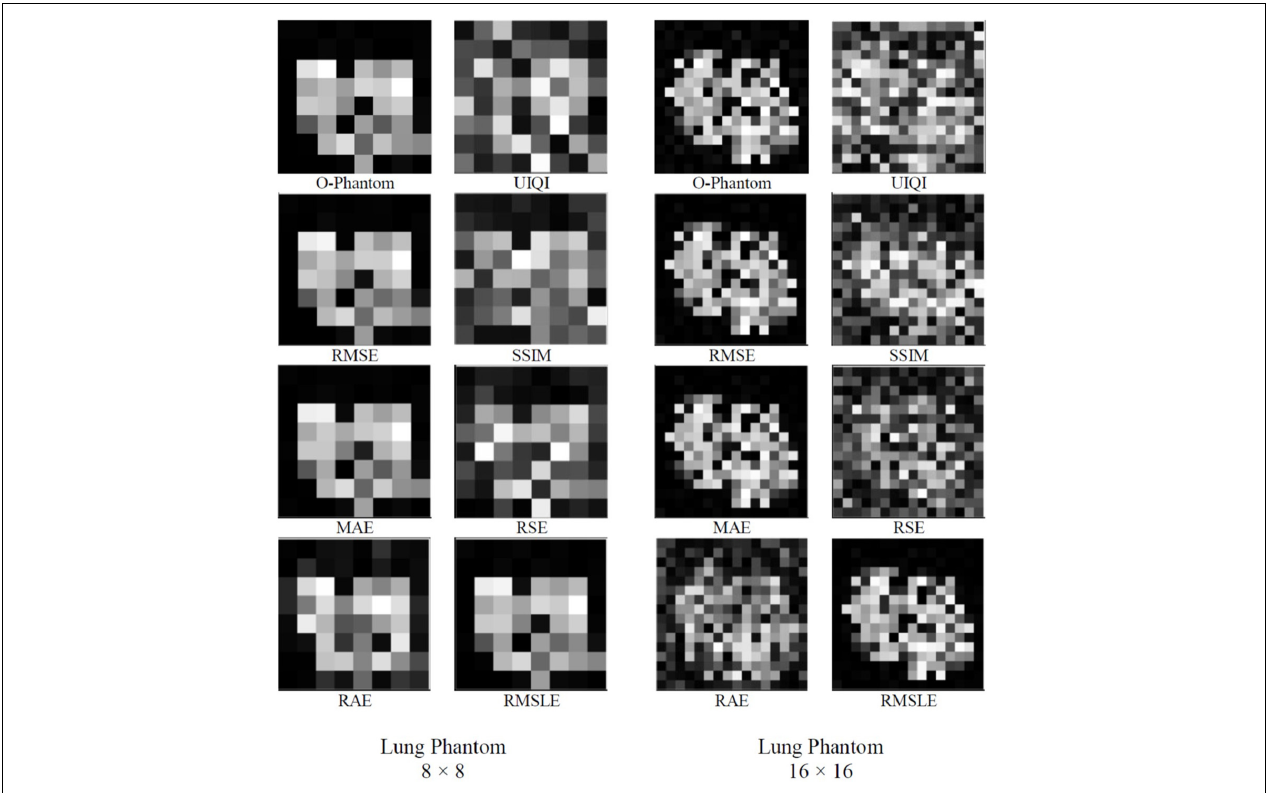
FIGURE 5 | Comparison between 8 × 8 and 16 × 16-sized image reconstruction using simulated annealing for the lung phantom, by using original phantom image, and cost functions (UIQI, RMSE, SSIM, MAE, RSE, RAE, and RMSLE) ( p = 18, T 0 = 0.1, T N = × 10 − 6 , N = 8 × 10 5 , temperature slab thickness set to 1000, and temperature profile as given by Eq. 4).